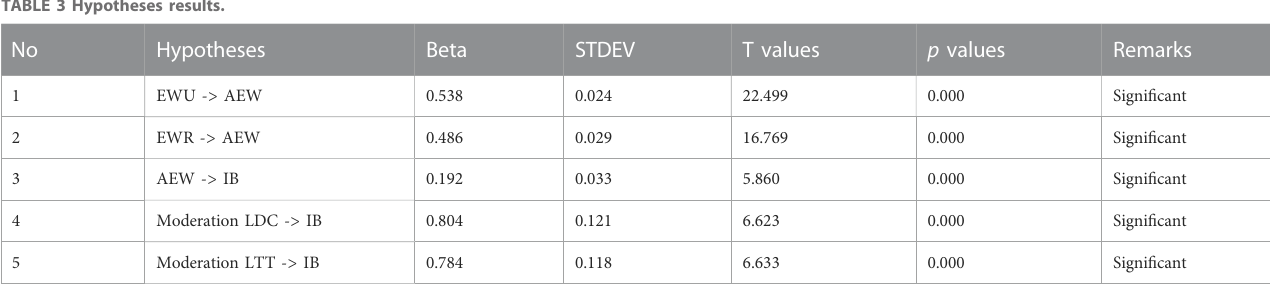
TABLE 3 Hypotheses